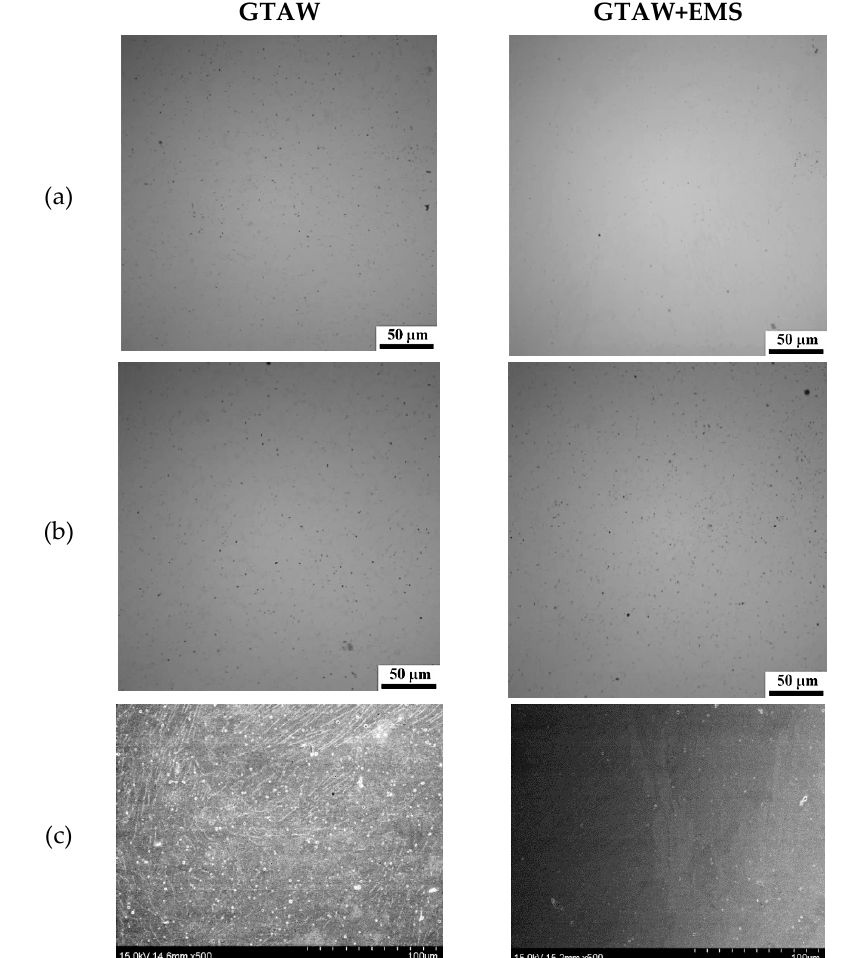
Figure 7. The micrographs of the GTAW/GTAW+EMS welds: ( a ) OM micrographs of unetched specimens in the cap region, ( b ) OM micrographs of unetched specimens in the root region, and ( c ) the secondary electron image (SEI) micrographs of the etched specimens in the cap region.